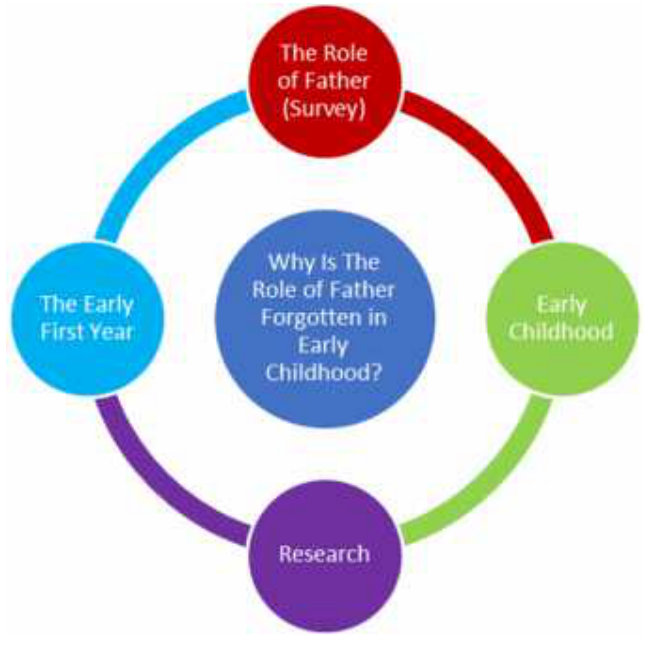
Fig 1 State of The Art the Role of The Father in The Early First Year of Early Childhood's